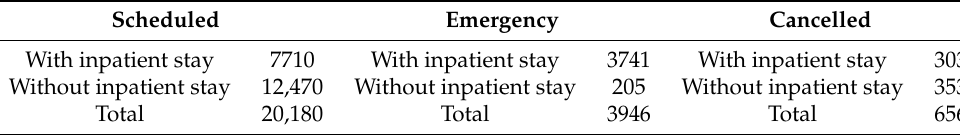
Table 1. Surgical Activity at the University Hospital Center per year.